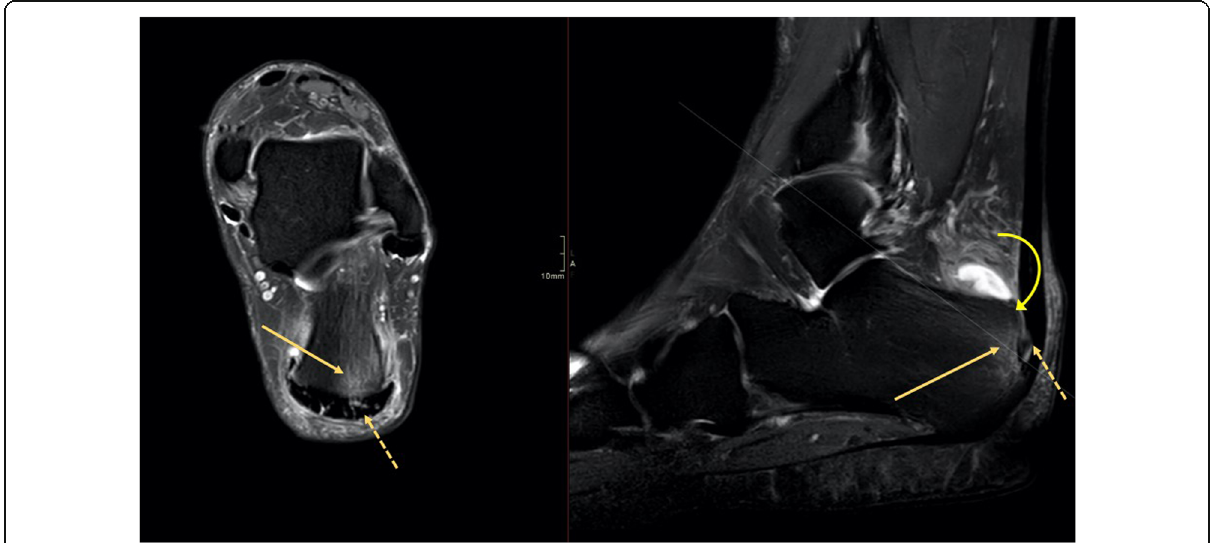
Fig. 10 A 49-year-old male with chronic pain at the Achilles tendon enthesis and suspicion of a Haglund deformity. MRI showed enthesopathy of the Achilles tendon (dashed arrow) and BME in the tuber calcanei (arrow) without evidence of a Haglund deformity (curved